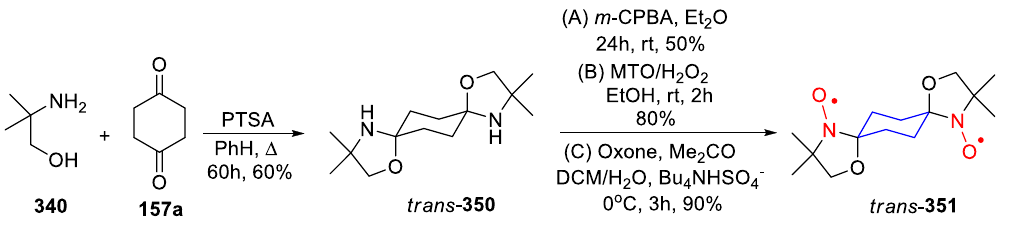
Table 3. Structures of available homo-SNBRs of the DOXYL type. Parent